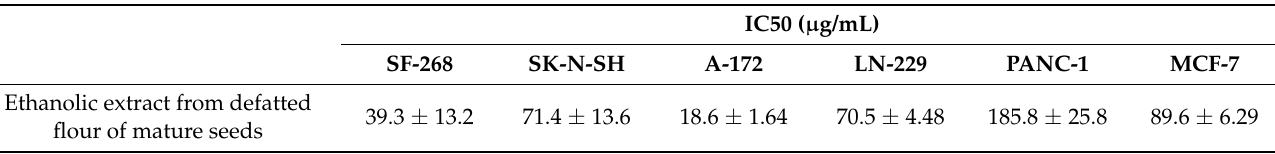
Table 5. Cytotoxicity activity (IC50) of the ethanolic extract from the defatted flour of Euphorbia lathyris in human glioblas- toma multiforme, pancreatic adenocarcinoma, and breast cancer cell